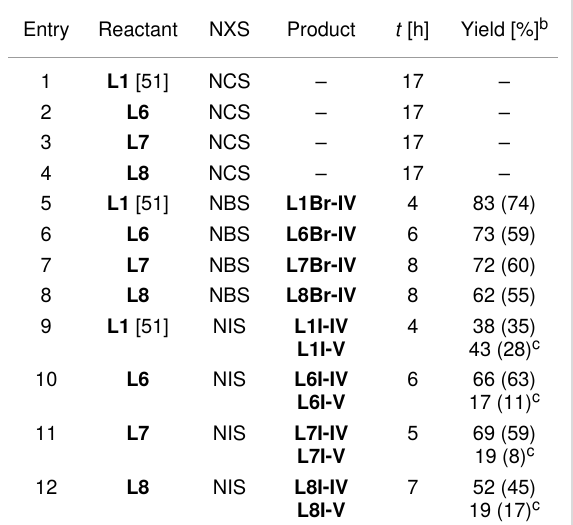
Table 2: Pd II -catalyzed halogenation of L1 [51] and its para -halo- genated derivatives ( L6 – 8 ). a